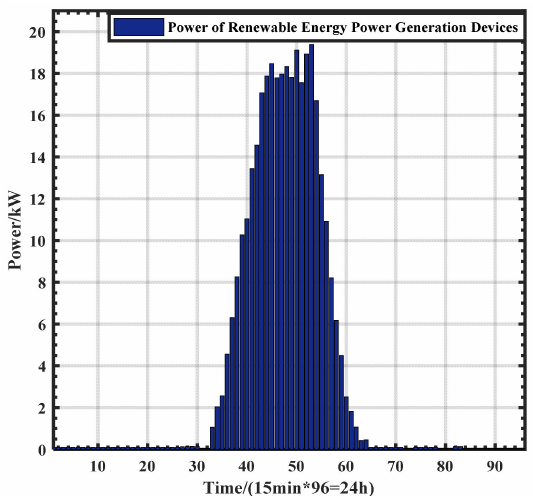
Figure A2. Power generation of renewable generation units of a 3 × 3 5G macro BS